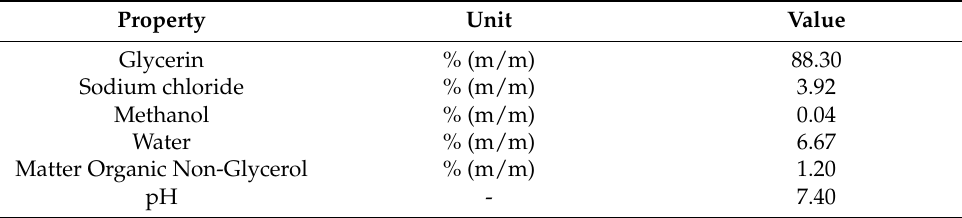
Table 3. The chemical composition of waste glycerol.